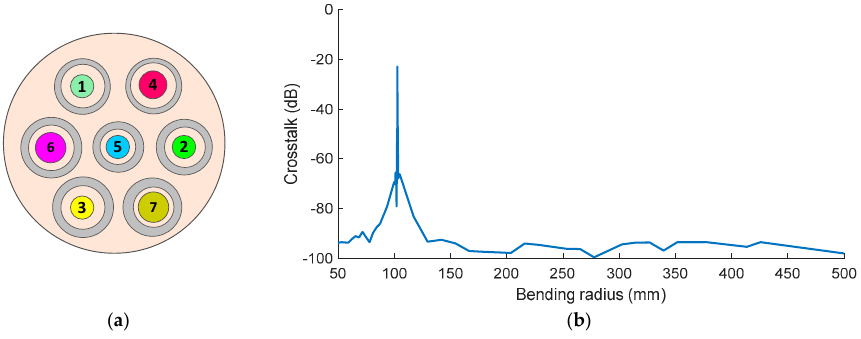
Figure 3. ( a ) Schematic cross section of the designed multicore fiber; and ( b ) computed worst-case crosstalk as a function of the bending radius [50]. Table 1. Core design parameters and computed fiber characteristics of the designed MCF [50].